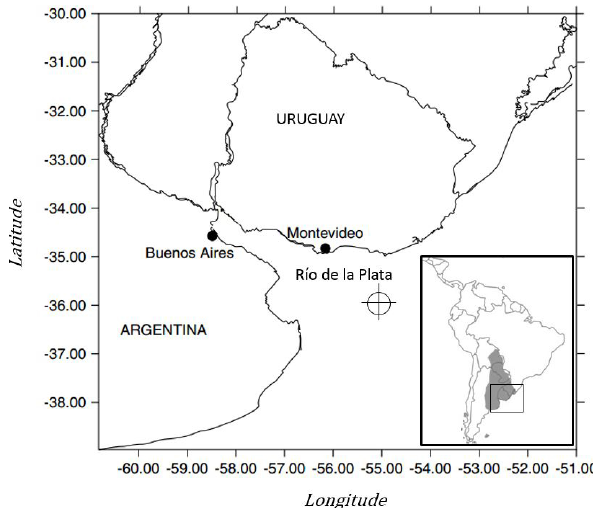
Figure 2. Location of the study site at the mouth of the Río de la